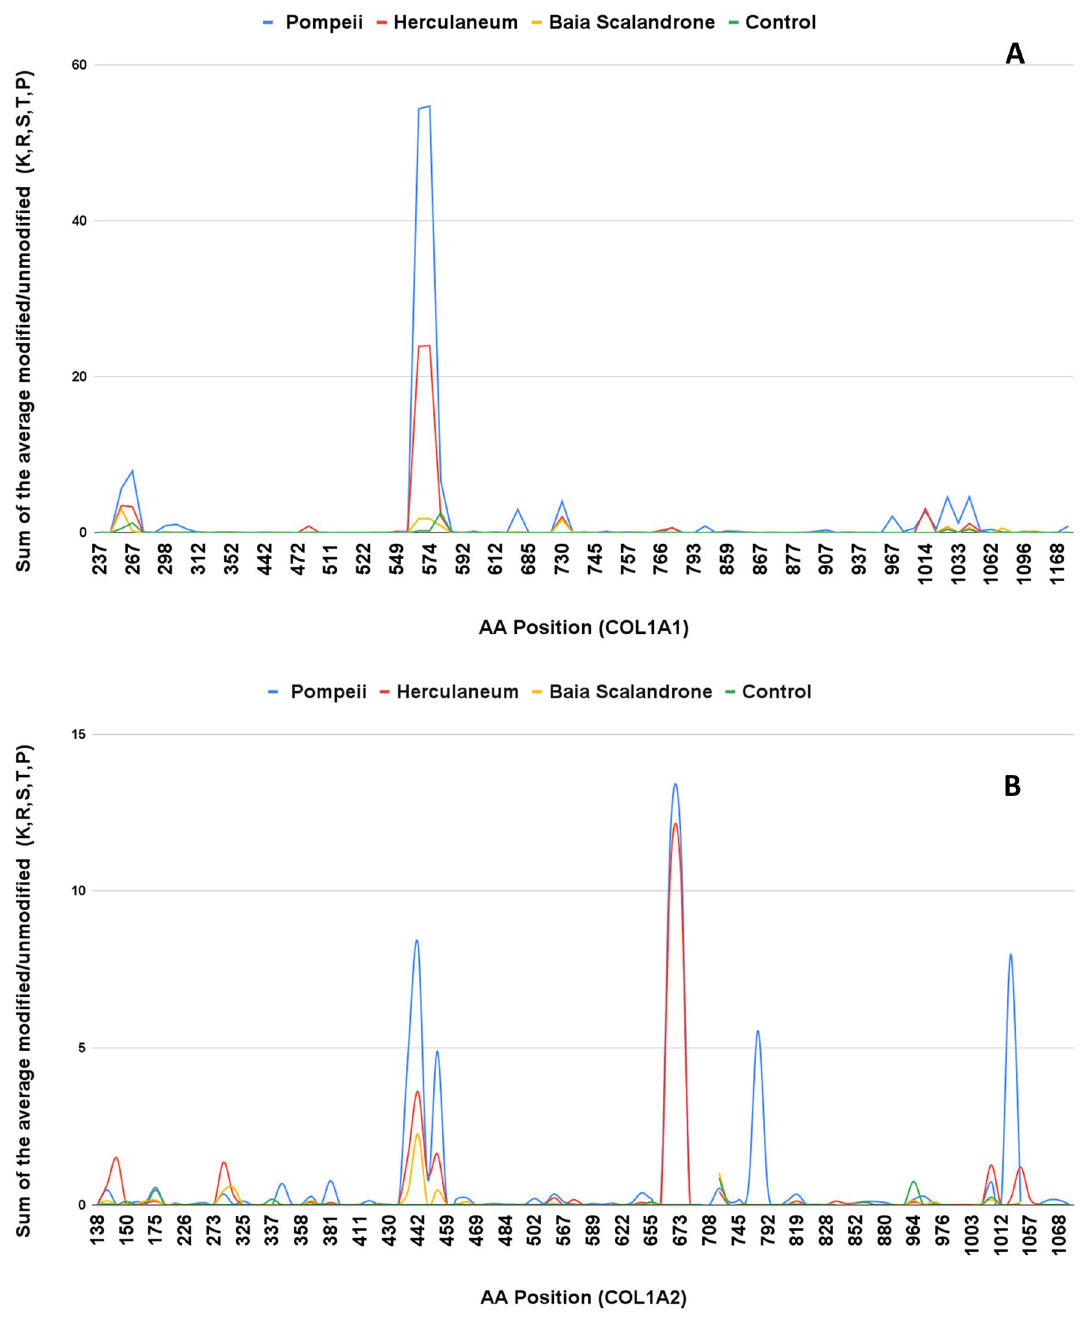
Figure 9. Comparative analysis of the global “damage signatures” in COL1A1 and COL1A2 from human bones of the different archaeological sites. The figure represents the sum of the average modified/unmodified values of K, R, S, T and P diagenetic modifications (except hydroxyproline and deamidation) at the specific primary structure positions of COL1A1 and